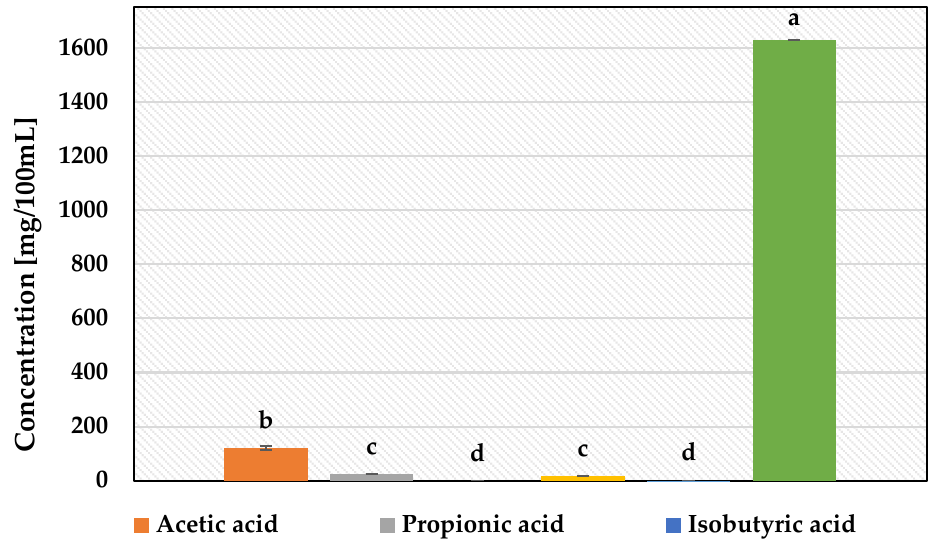
Figure 6. Fermentation by-products of the L. plantarum KB2 LAB 03 cultured on A100 M100 acid whey-based medium. a–d—results with different letters are significantly different (Tukey’s test, α = 0.05).